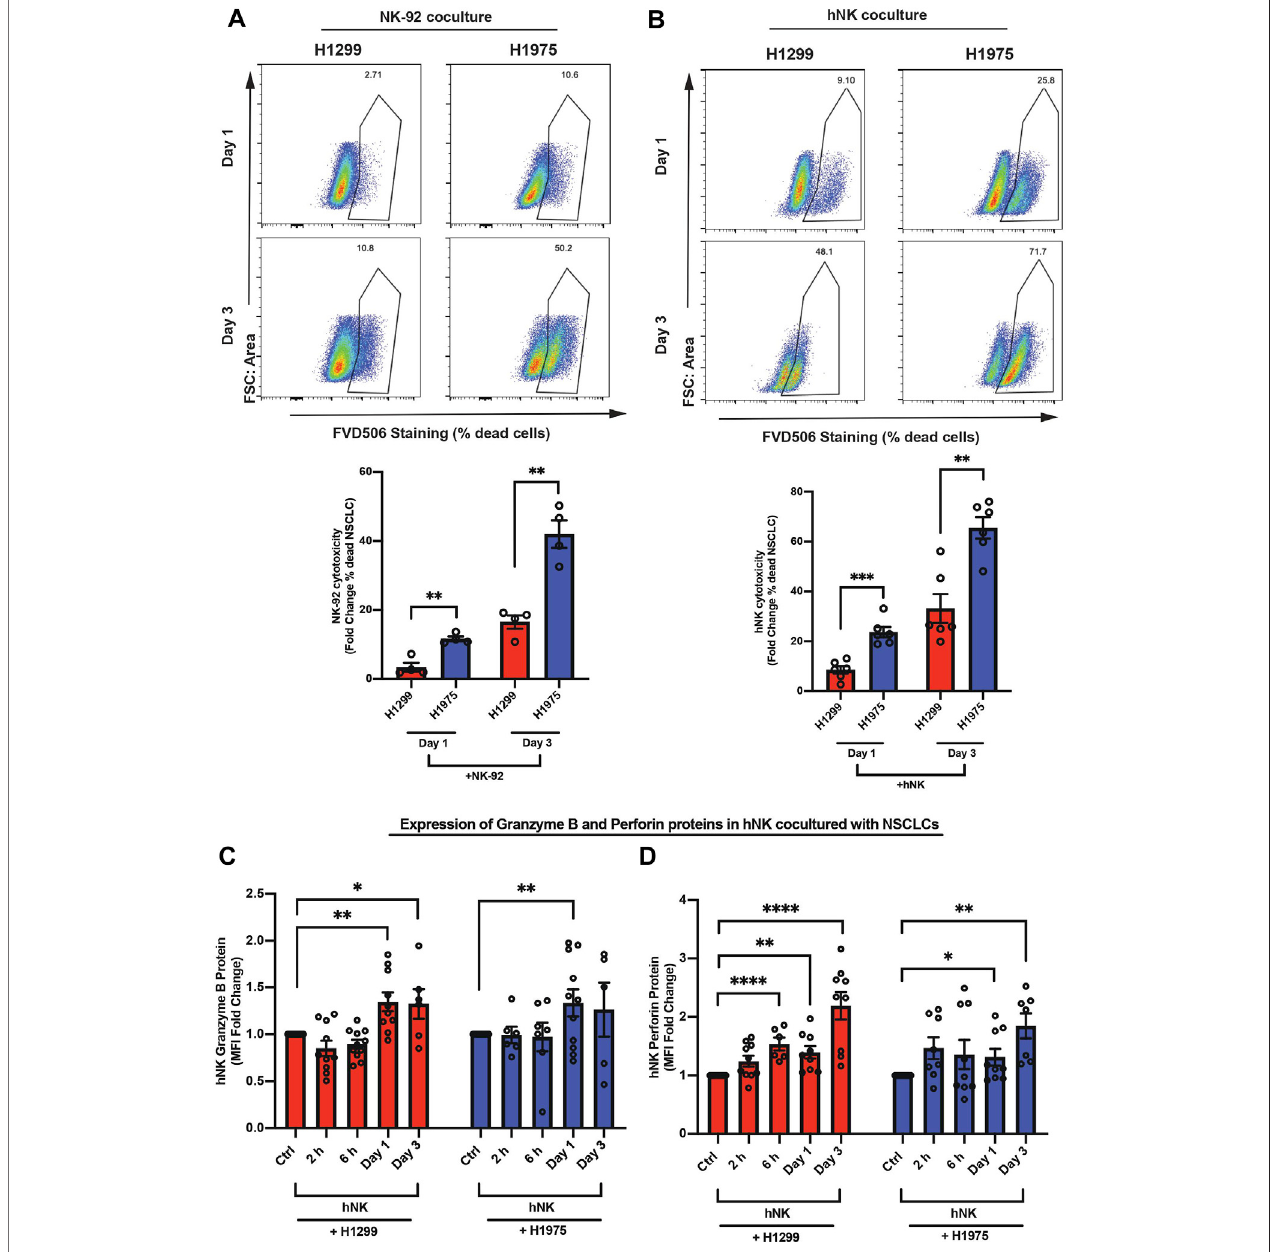
FIGURE1| NSCLCsweresusceptibletoNKcellkilling.Flowcytometryanalysesshow: (A,B) Representativeandquanti fi edpercentageofdeadNSCLCs(FVD506 positive). The NSCLCs wereCFSE stained prior tococulture with NK-92 (A) or hNK (B) cells; n =4for NK-92 coculture. n = 6for hNK coculture. Dataare representative ofthreedonorsforhNKcells;Gatingstrategyispresentedin SupplementaryFigure1C . (C,D) ThehNKmedian fl uorescenceintensity(MFI)foldchangeofgranzymeB andperforinproteinsinhNKcellscoculturedwithNSCLCswereanalyzedby fl owcytometryatindicatedtimepointsandcomparedtocontrolhNKcells.Thegraphs represent means ± SEM; n ≥ 6 and representative of four donors. One way ANOVA test was used to compare across conditions.